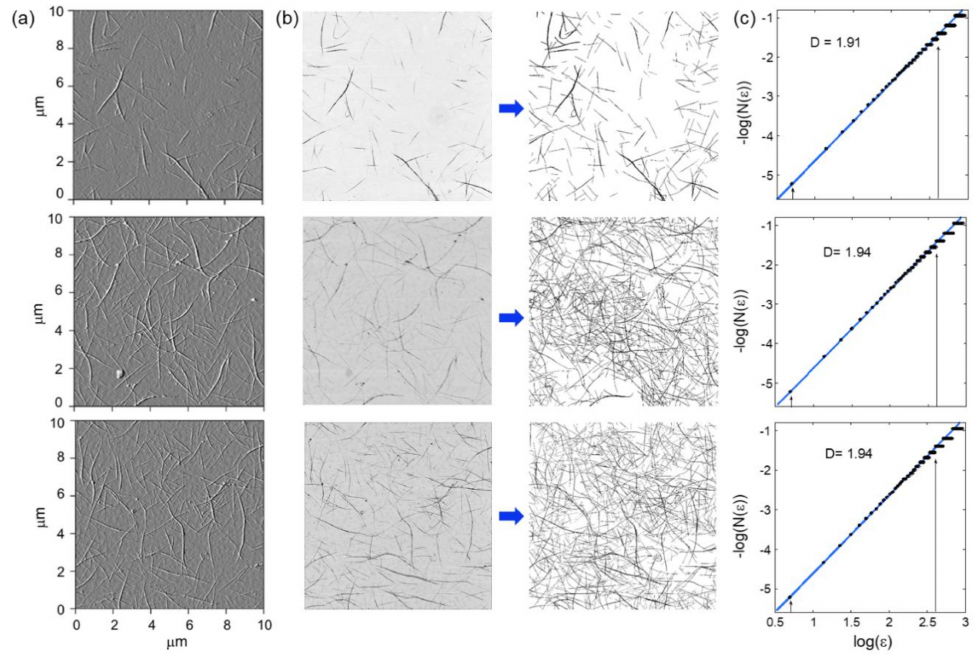
Figure 4. Fractal analysis of a random CNT thin film network structure. ( a ) Atomic force microscopy (AFM) images of typical CNT thin film networks (note the presence of bundles). ( b ) To perform the fractal analysis, these images were converted to black and white bitmap images. ( c ) The associated box-counting fractal analysis plots, where the log of the minimum number of boxes, N ( ε ), required to cover the network is plotted with box size, ε . The linearity of the plot indicates the network is fractal, and the slope of the best fit line indicates the fractal dimension D , indicated for each image shown on the graph. The arrows indicate the expected limits to assess D